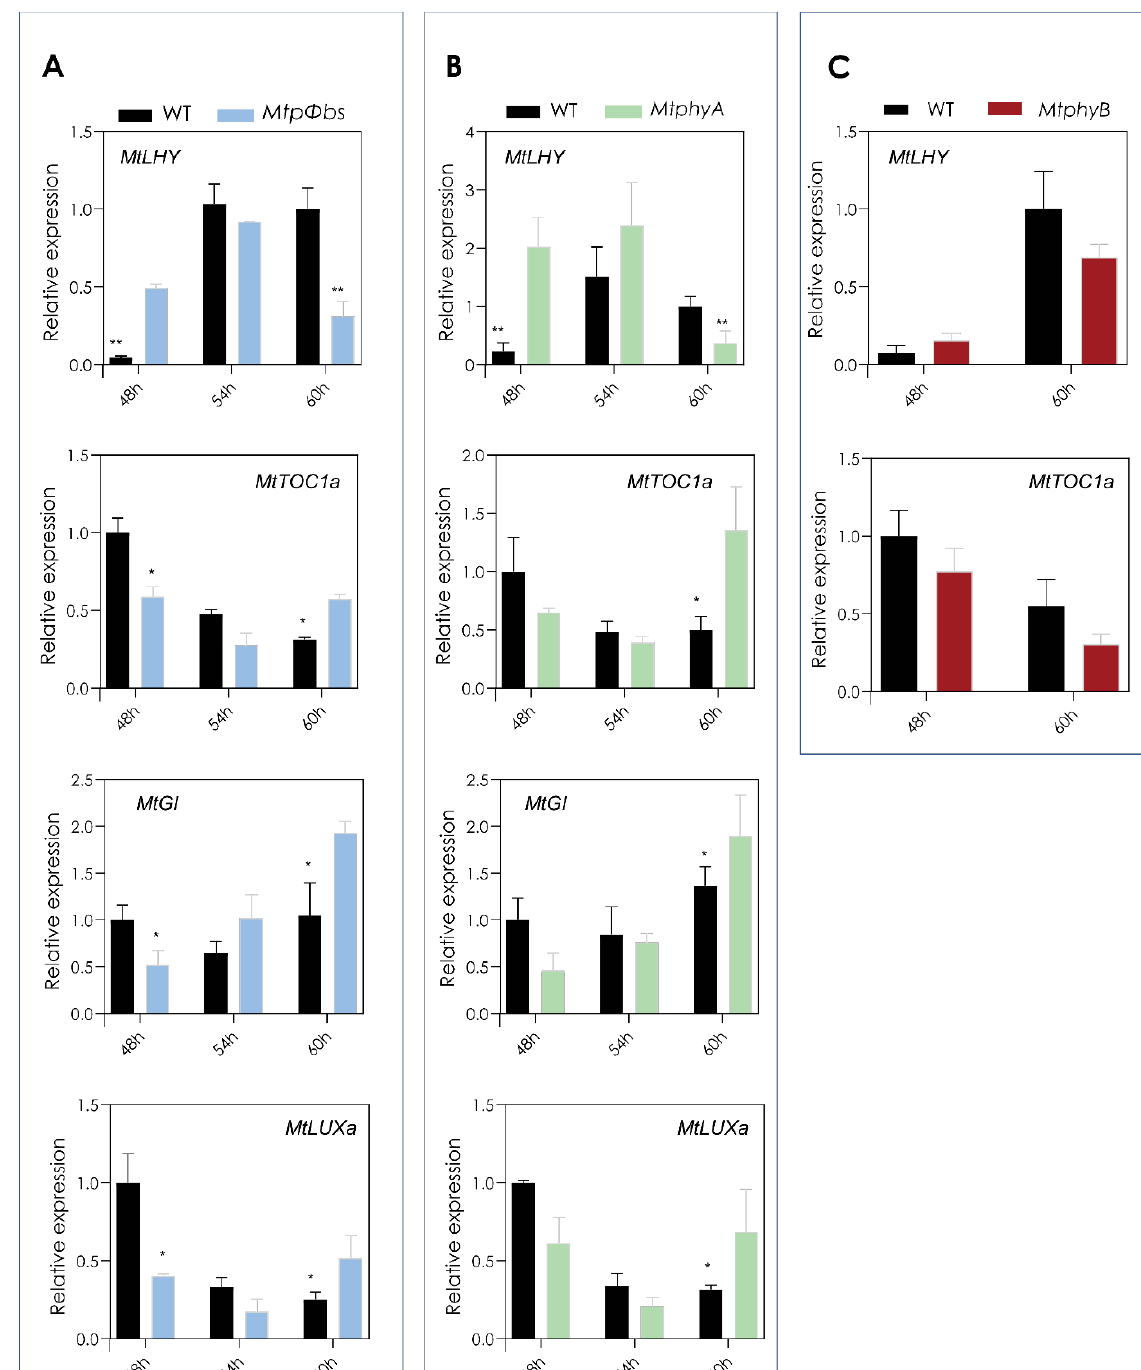
Figure 6. The MtpΦbs mutant has a shift in expression of the core clock genes. Gene expression of core clock genes in ( A ) Mtpφbs , ( B ) MtphyA and ( C ) MtphyB mutants, and respective WT in LL3. Relative transcript abundance was measured in the fully expanded trifoliate leaves of 24-day-old plants. Tissues were harvested every 6 h after dawn of the third day in LL after being entrained in LD for 21 days. Relative gene expression was measured by qRT-PCR with normalization to MtPDF2 . Data are the mean ± SEM of three biological replicates and relative to the highest WT value. ** p < 0.01, * p < 0.05 (Student t -test). LD = long-day (16 h light/8 h dark). LL3 = third day of free-running conditions (constant light).